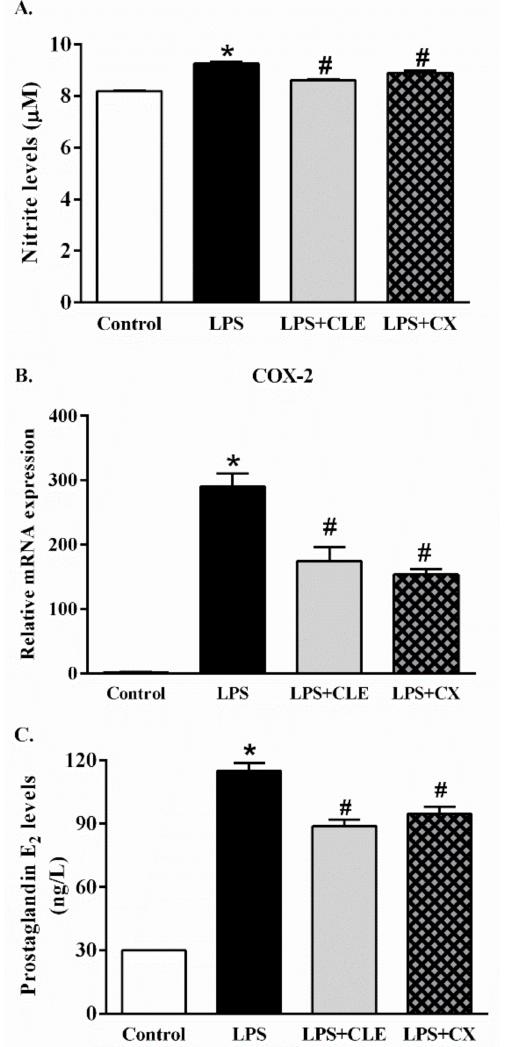
Figure 4. The effects of CLE on NO production, COX2 gene expression, and PGE2 production in LPS-stimulated RAW 264.7 cells. RAW 264.7 cells were supplemented with CLE or CX in the presence or absence of LPS for 24 h. The production of NO ( A ), the expression of cyclooxygenase-2 (COX-2) ( B ), and prostaglandin E2 (PGE2) levels ( C ) were evaluated. Values shown are mean ± SEM ( n = 5); * p < 0.05 vs. control and # p < 0.05 vs.